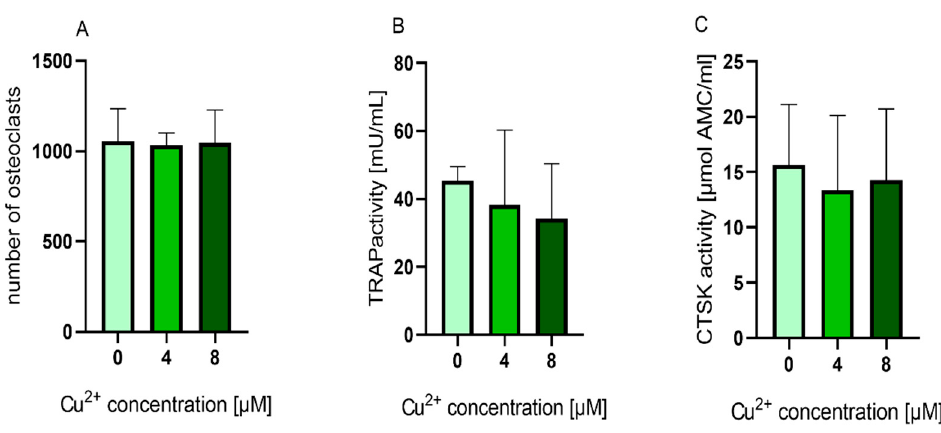
Figure 8. ( A ) Number of multinucleated TRAP positive osteoclasts counted from light microscopic images (cells of two donors, 4 images per condition) Statistic differences were calculated by one-way ANOVA, followed by Tukey’s test for multiple comparisons ( B ) TRAP activity and ( C ) CTSK activity of mature osteoclasts cultivated in the presence of 0, 4 and 8 µM Cu 2+ . Data of four different donors were included into the calculation with each n = 3 replicates per group (average +/ − standard deviation). TRAP and CTSK activities were normalized to the copper free control, since the enzyme activity levels between the different donors showed high variances. Statistical significant differences were calculated by one way ANOVA followed by Tukey’s test to perform multiple comparisons. * p < 0.05 compared to the control.